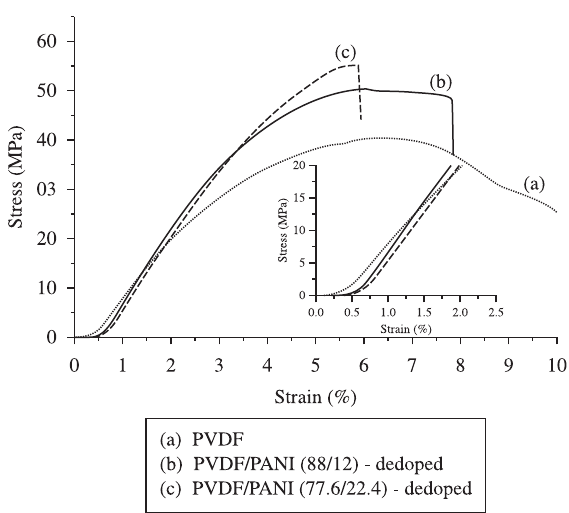
Figure 12. Stress-strain curves of: a) PVDF; b) PVDF/PANI (12 wt. (%) PANI); and c) PVDF/PANI (22,4 wt. (%) PANI). The blends were redoped with HCl 1,0